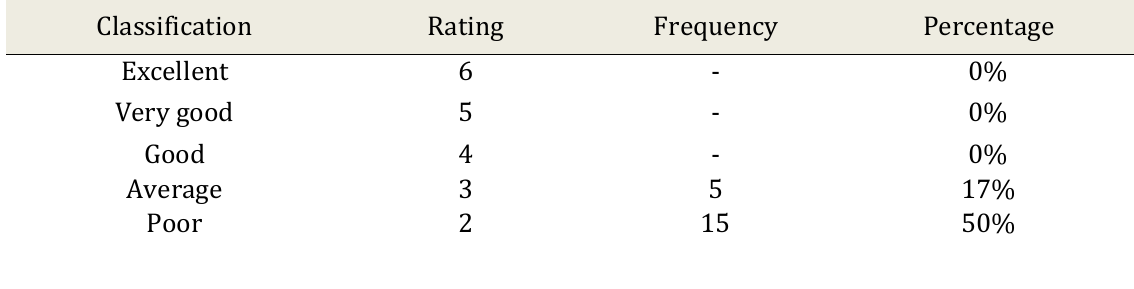
Table 4.20 The Rate Percentage Score of Students' Comprehensibility in Pretest Result in